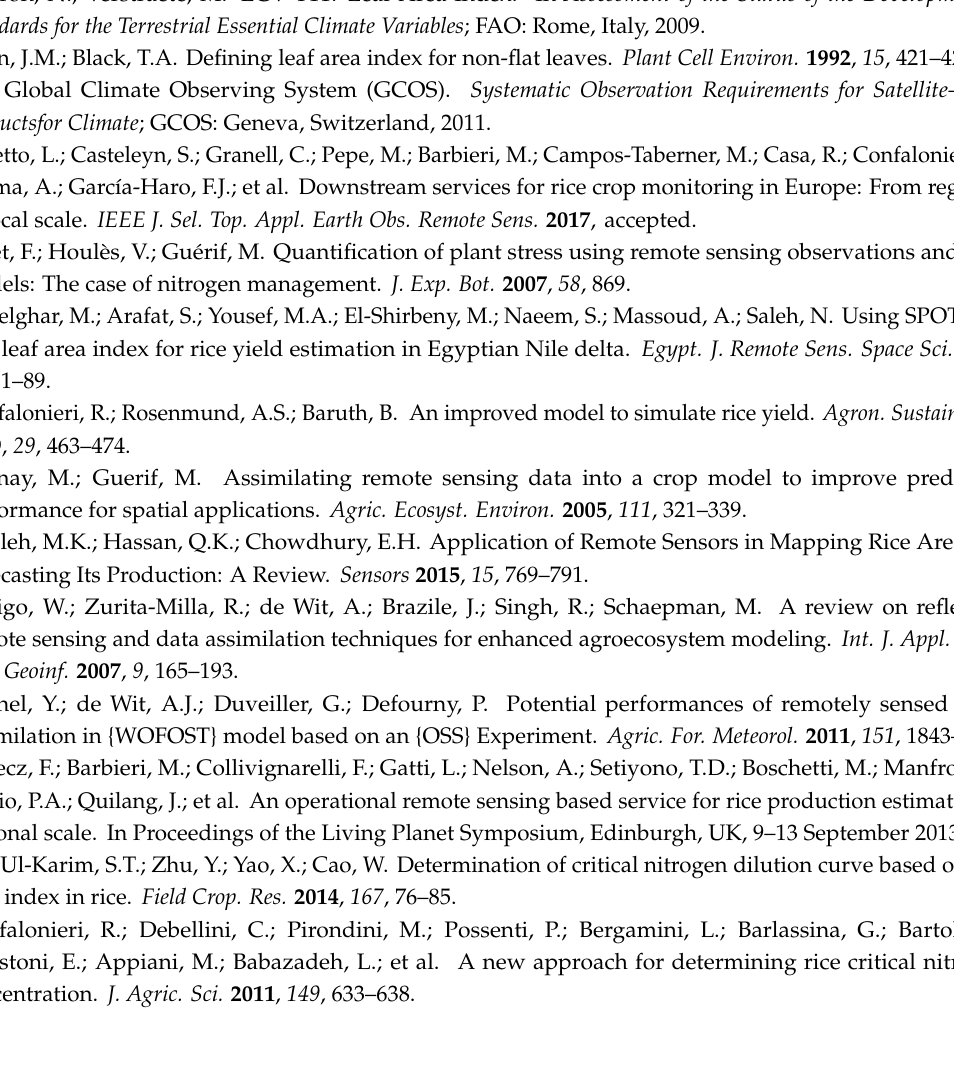
Table S1: Recap of available optical remote sensing data over each study area during the 2016 rice season. Table S2: Confusion matrices related to rice crop maps. Table S3: Metrics of the statistical